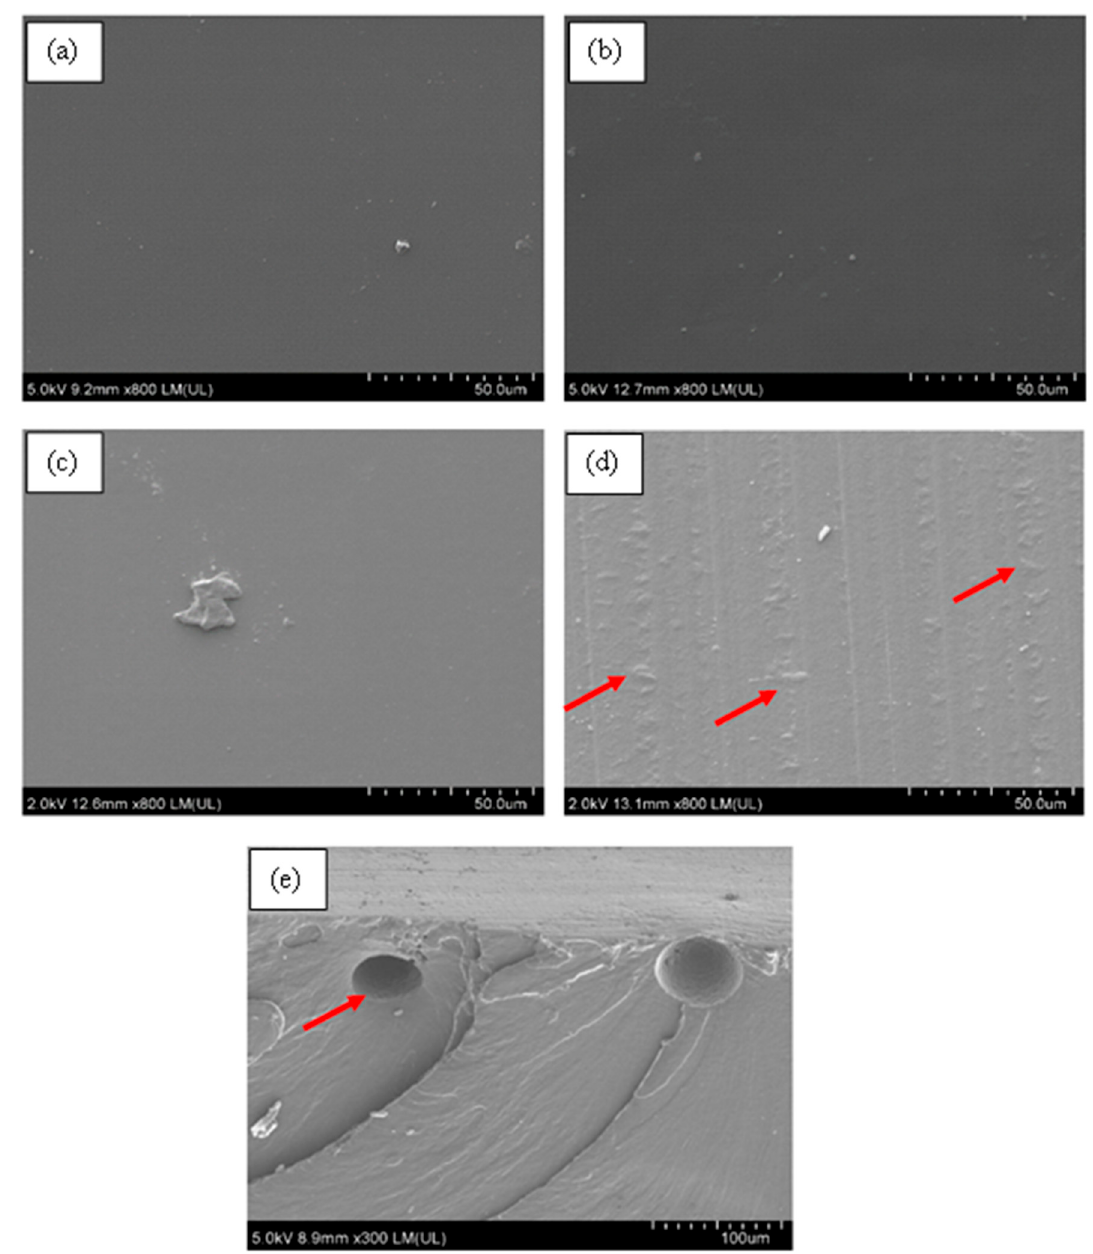
Figure 14. PU at magnification × 800 with ( a ) 0.2% HFNS, ( b ) 0.4% HFNS, ( c ) 0.6% HFNS, ( d ) 1% HFNS, and ( e ) fracture surface of PU-0.4% HFNS at magnification of × 300.